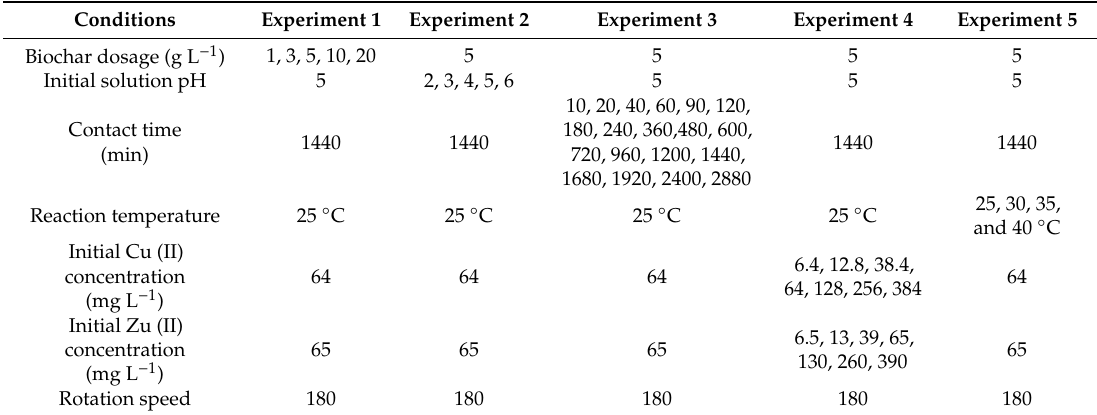
Table 2. The operating conditions of the